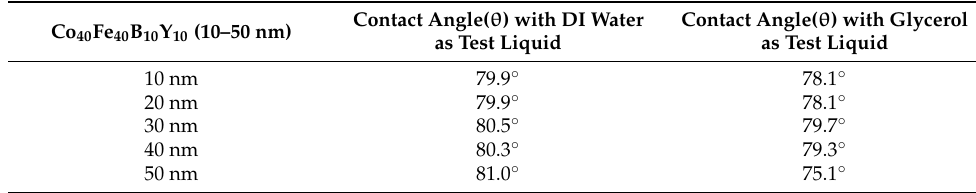
Table 4. Average contact angles of CoFeBY thin films after annealing at 100 ◦ C with DI water and glycerol.